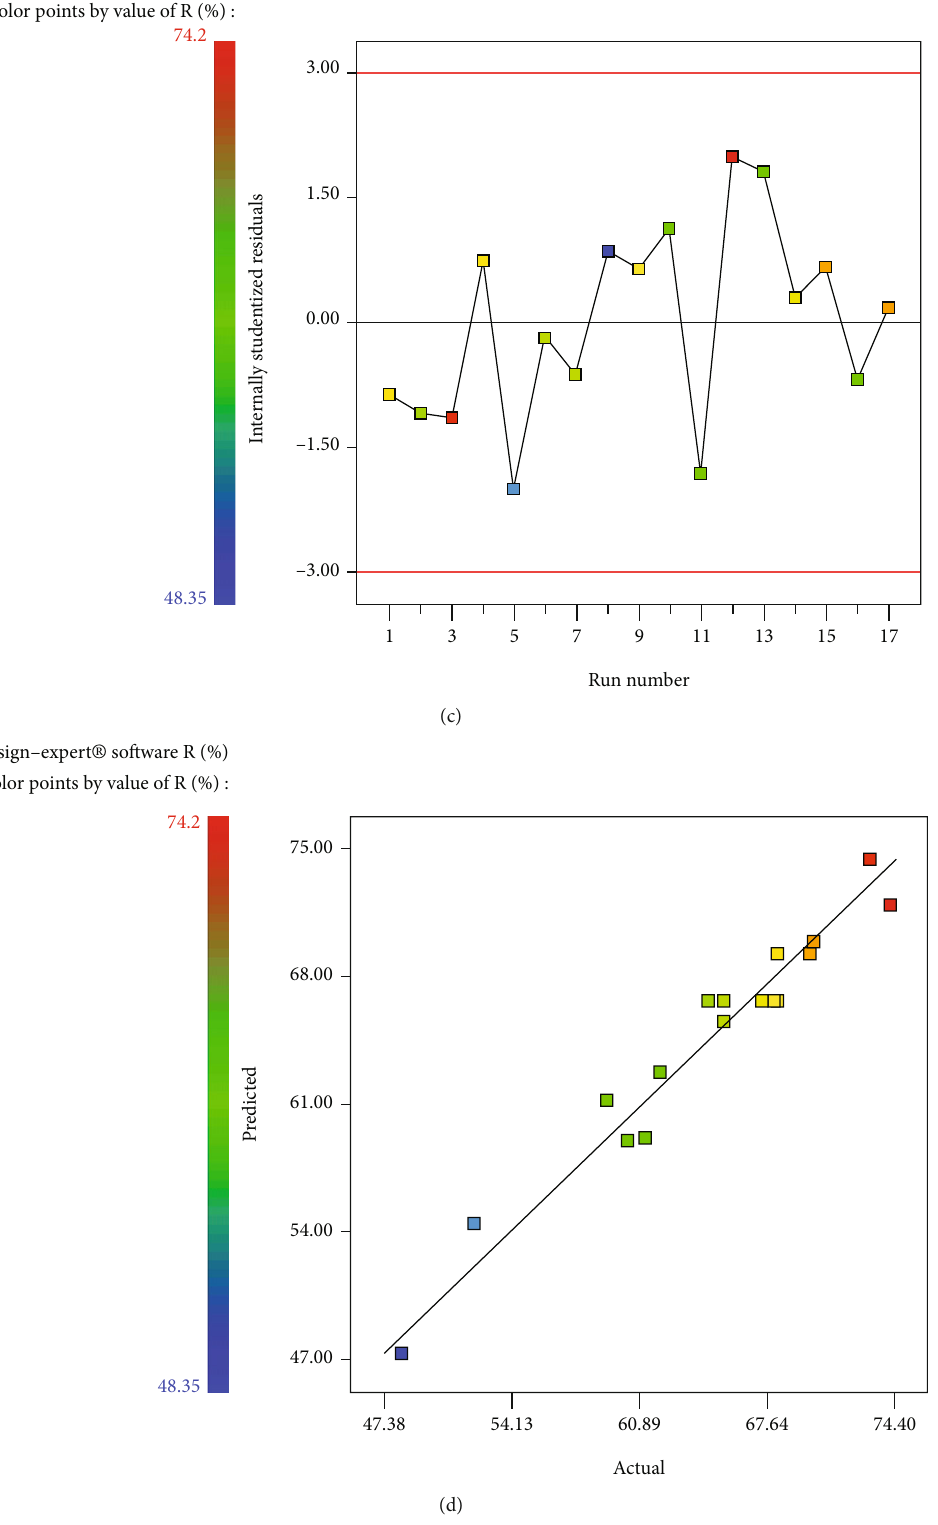
Figure 5: (a) Normal probability of student residuals. (b) Residuals versus predicted. (c) Residuals versus run number. (d) Measured values versus predicted